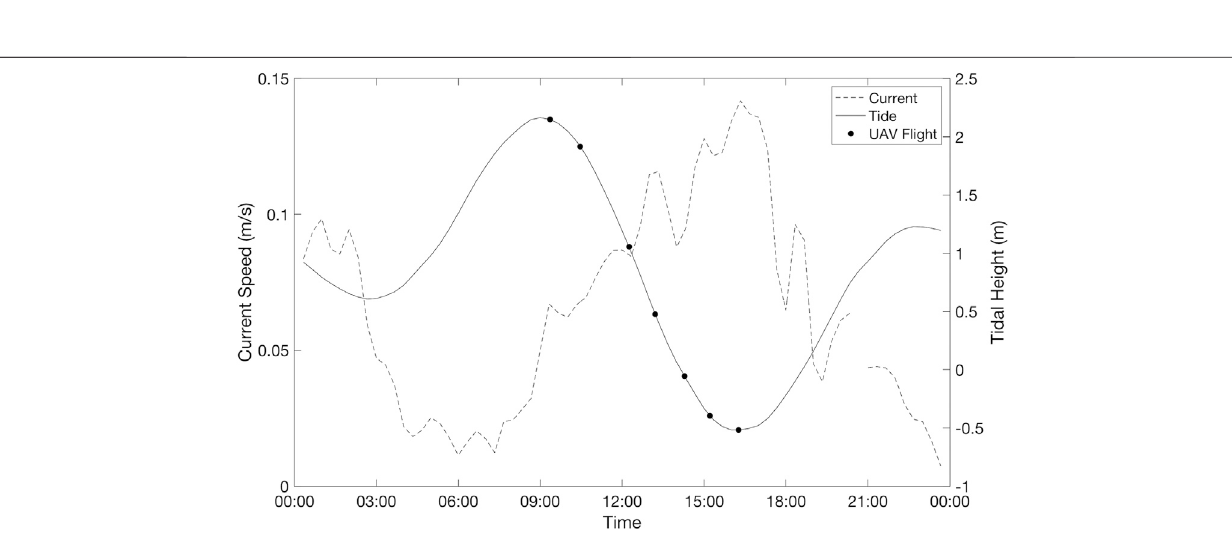
Frontiers in Environmental Science |